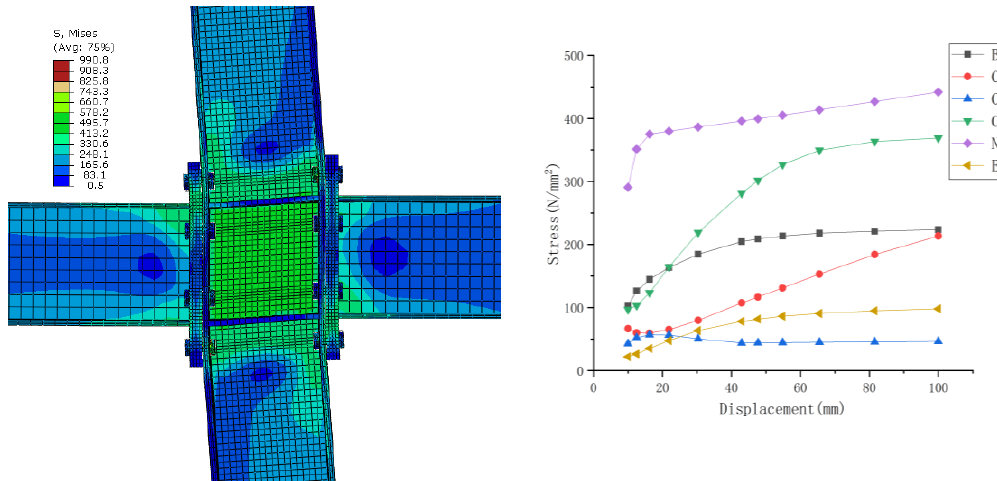
Figure 14. Stress distribution and stress history at specified points of a 16-mm end-plate.